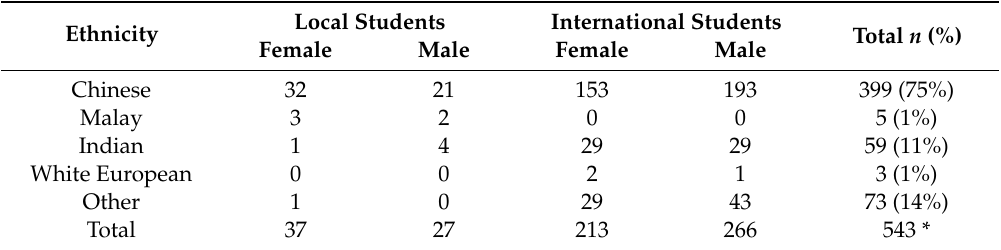
Table 1. Total number of local and international students by ethnicity and